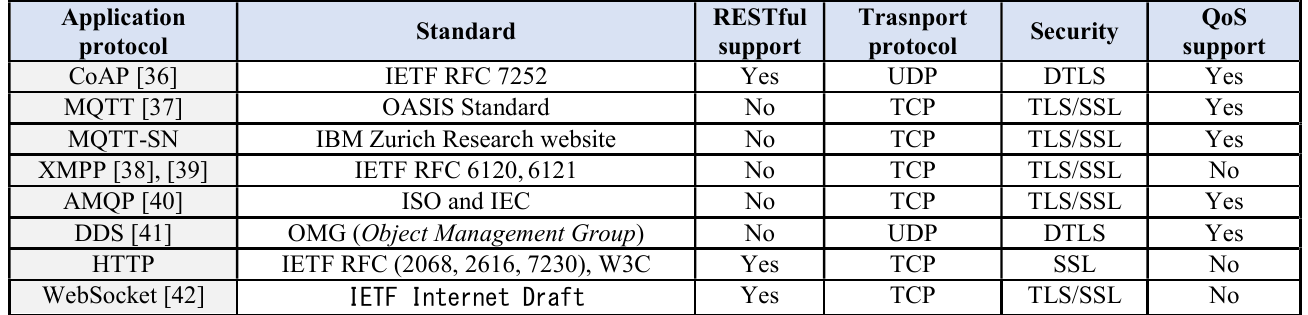
Table 1. Application layer protocols for